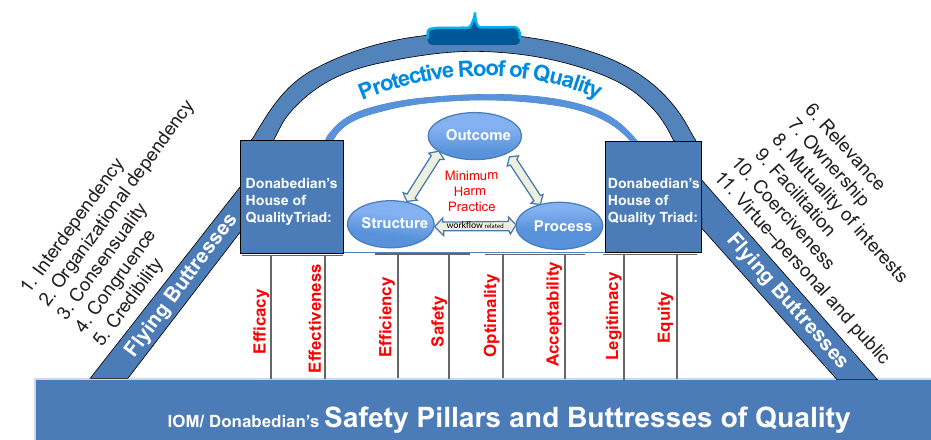
Figure 4. Donabedian house of quality on sound foundation and lateral supports.